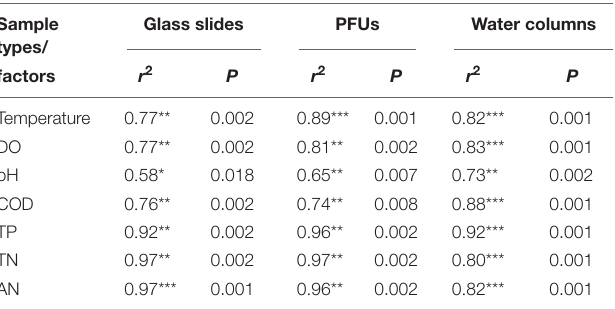
TABLE 2 | The correlation coefficient between the microeukaryotic community structure and environmental factors and result of Monte Carlo permutation test in different sample